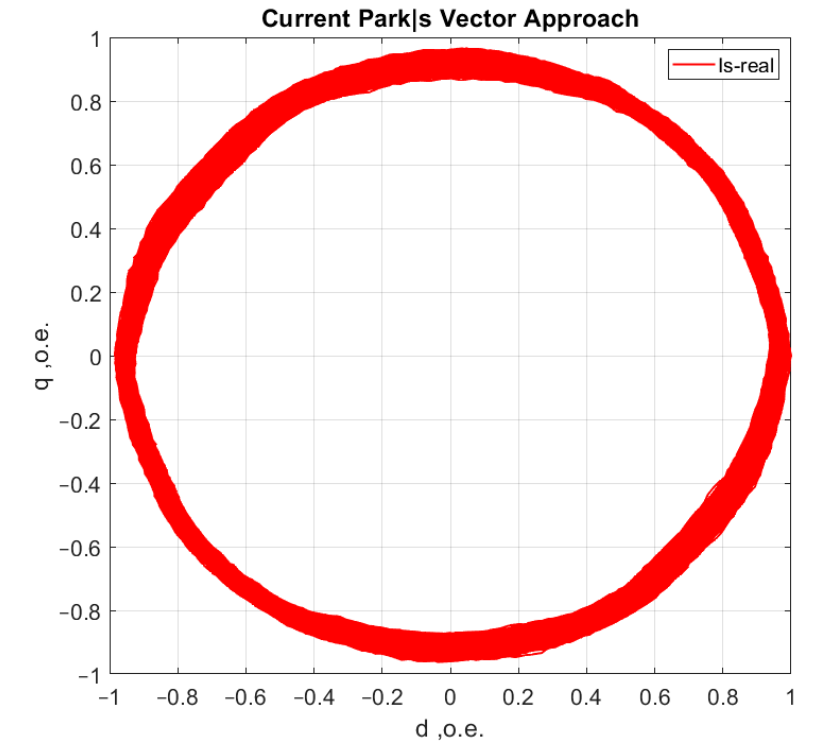
Figure 12. The hodograph at medium defect.